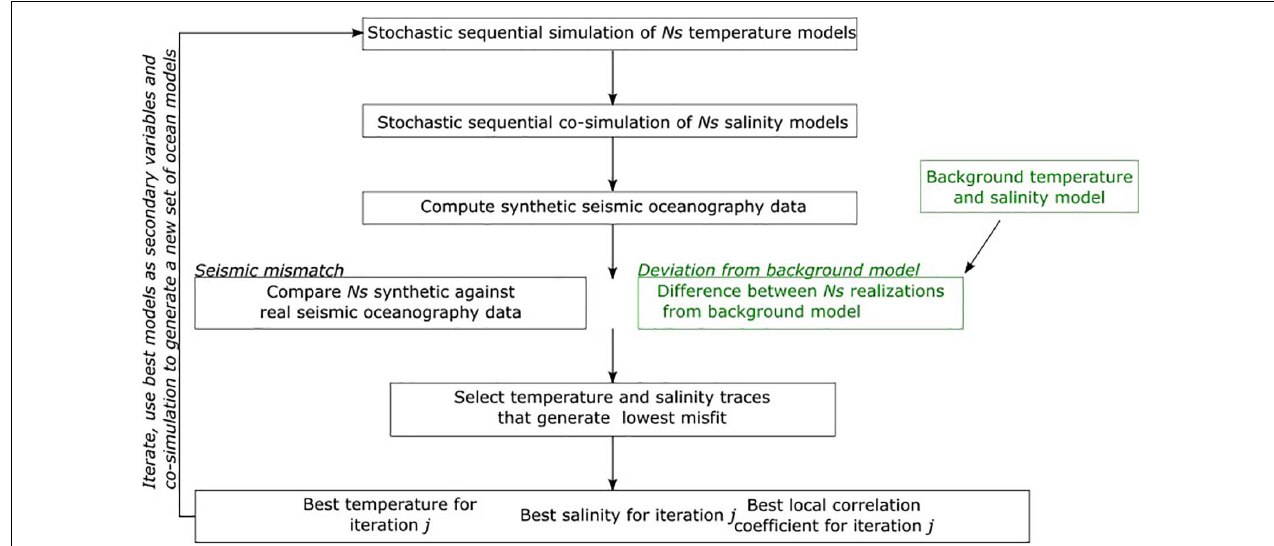
FIGURE 1 | Schematic representation of the proposed geostatistical SO inversion including temperature and salinity background models. Green boxes represent the steps related to the integration of background ocean